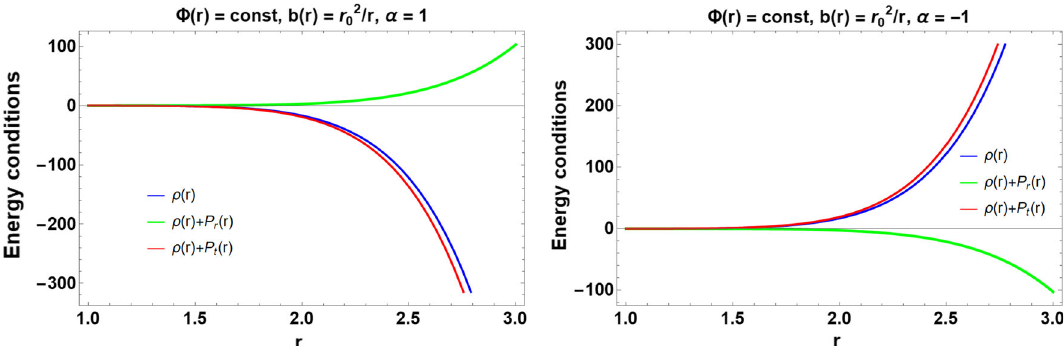
Fig. 1 The figure represents the energy density and the null energy graphical behavior for r 0 = 1 and α = ± 1. The NEC given in Eqs. (24) condition (NEC) for radial and tangential directions for the specific and (25) is violated at the throat r = r 0 irrespective of α / r . We present the case of f ( Q ) = Q + α , (cid:10) (cid:5) ( r ) = 0 and b ( r ) = r 2 0 Q